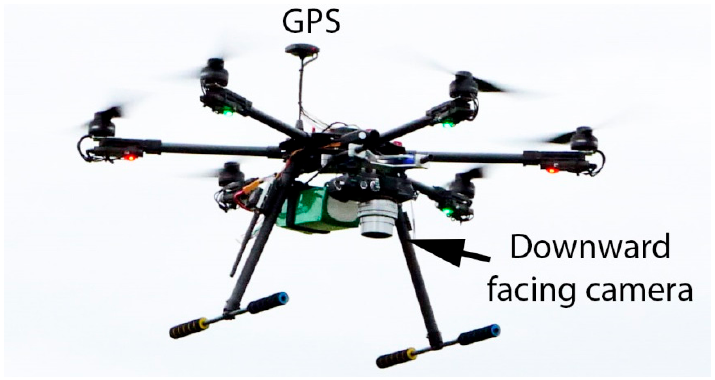
Figure 3. Hex-copter with GPS and downward facing camera.